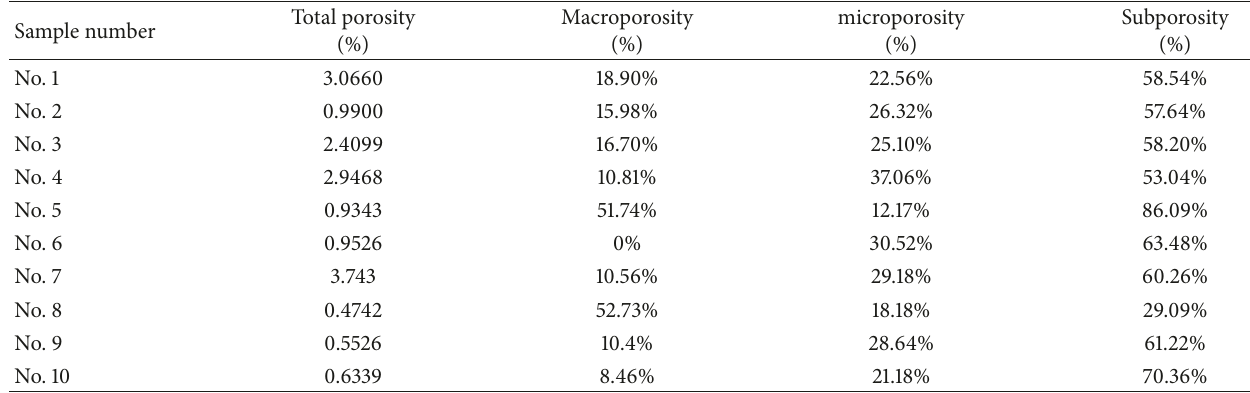
Table 1: Classification of the pore size of rock salt.